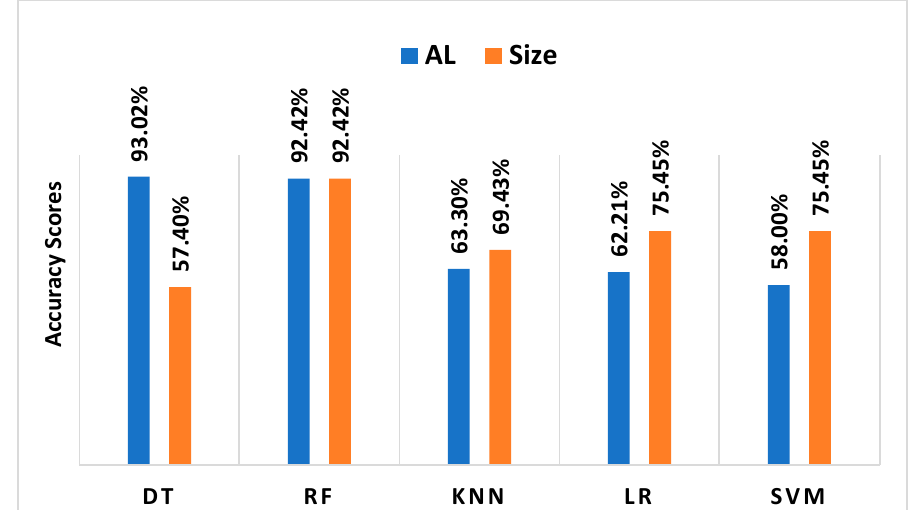
Figure 7. Algorithms test performances on AL and size selection.